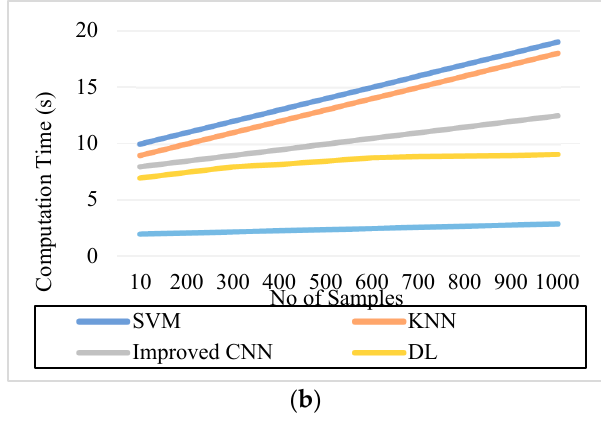
Figure 9. Computation time. ( a ). IDRiR and ( b ) Messidor.